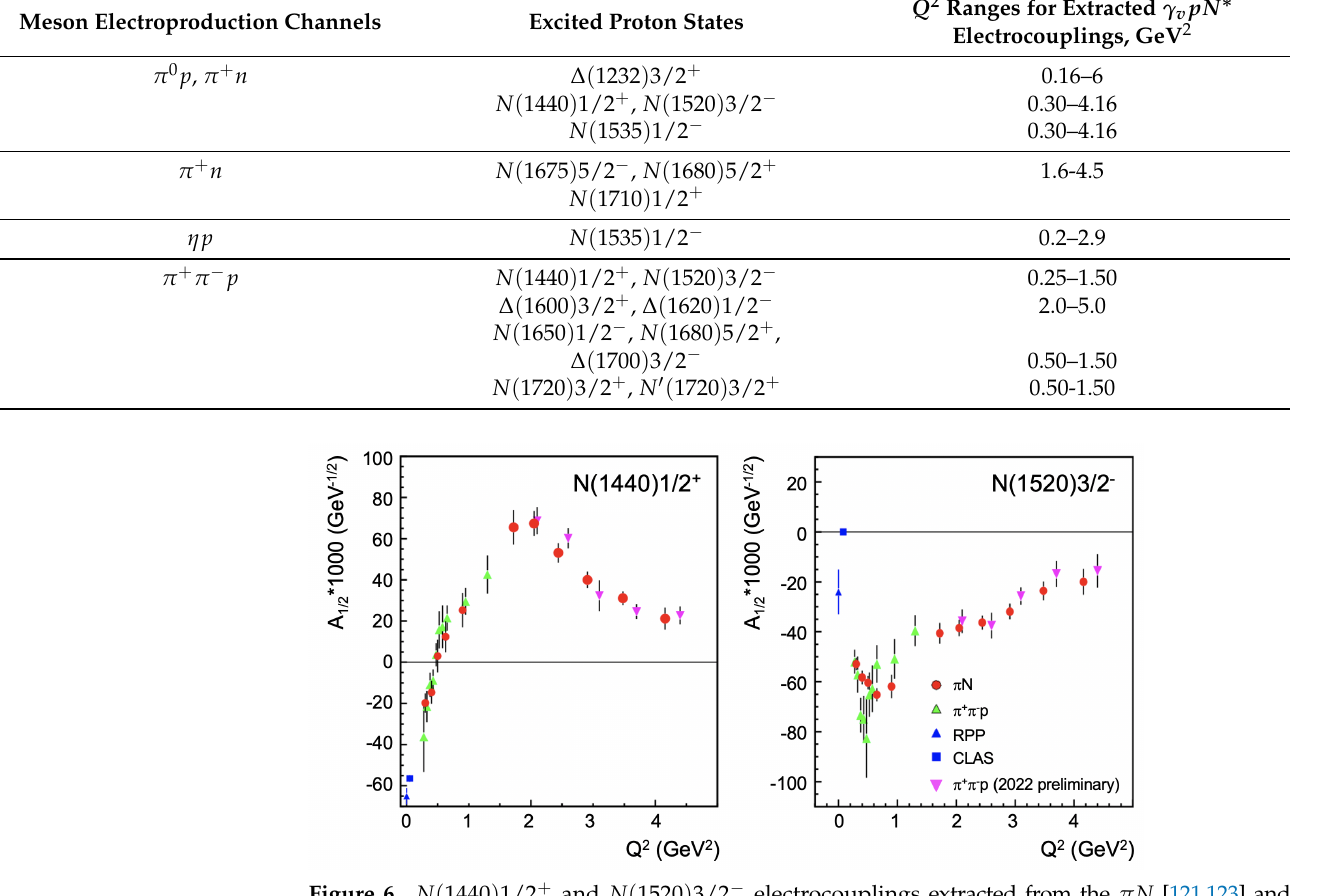
Figure 6. N ( 1440 ) 1/2 + and N ( 1520 ) 3/2 − electrocouplings extracted from the π N [121,123] and π + π − p [67,83,136,137] electroproduction channels. The photocouplings from the Review of Particle Properties (RPP) [76] and from Reference [138] are shown by the blue squares and triangles,